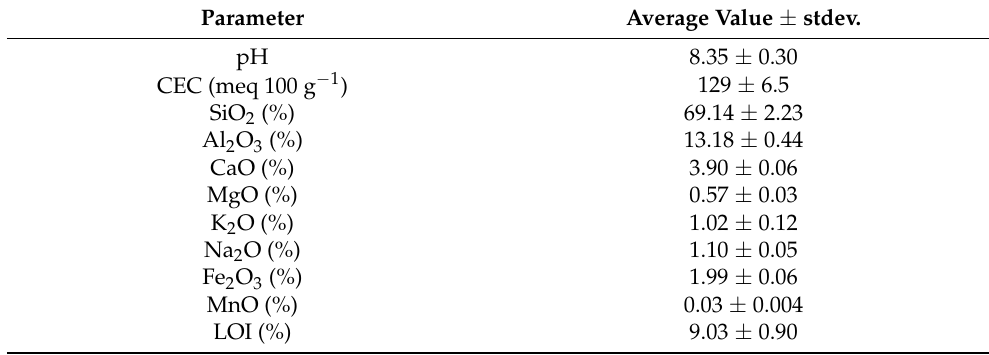
Table 1. Chemical composition of zeolitic tuff from Macicasu quarry (n = 3 parallel determinations). Parameter Average Value ± stdev.